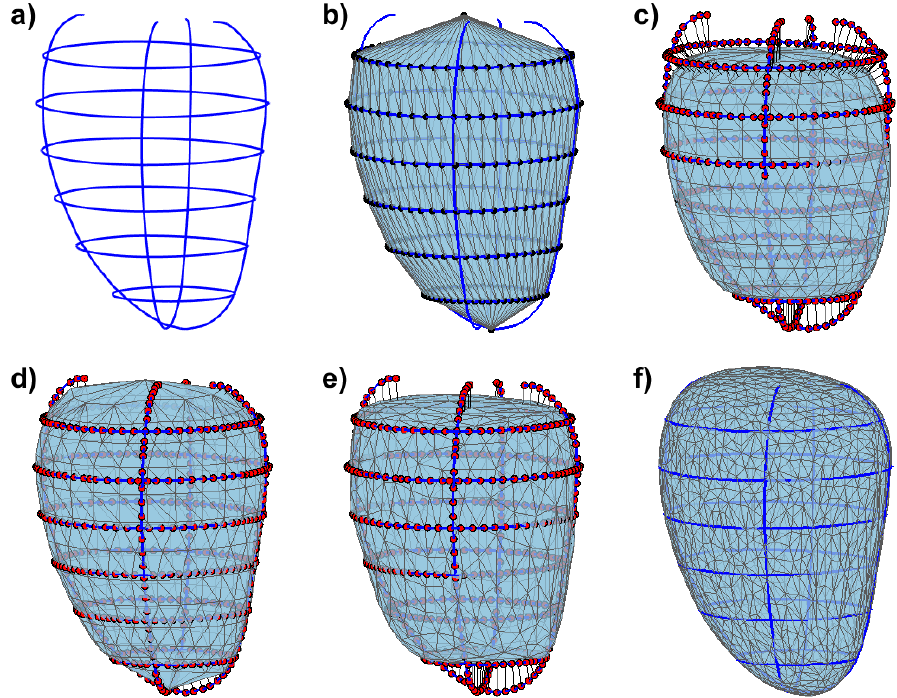
Figure 2. Overall pipeline for generating a surface mesh from contours illustrated on left epicardial contours. ( a ) the input contours; ( b ) tubular initial mesh with its vertices equally spaced along the contours; ( c ) the initial mesh after the Laplacian smoothing and showing the attractor points on the contours, with a visual illustration of their connections pulling the mesh; ( d ) the resulting mesh after several small deformations towards the attractor points; ( e ) the mesh after having undergone the process of subdivision, smoothing and decimation; ( f ) the resulting mesh, after several iteration of steps ( d , e